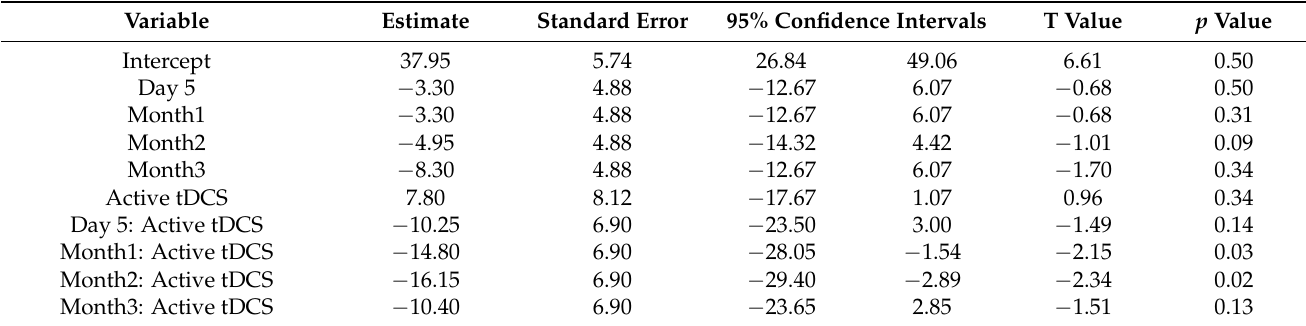
Table 3. Profile analysis results for Pain Numeric Rating Scale